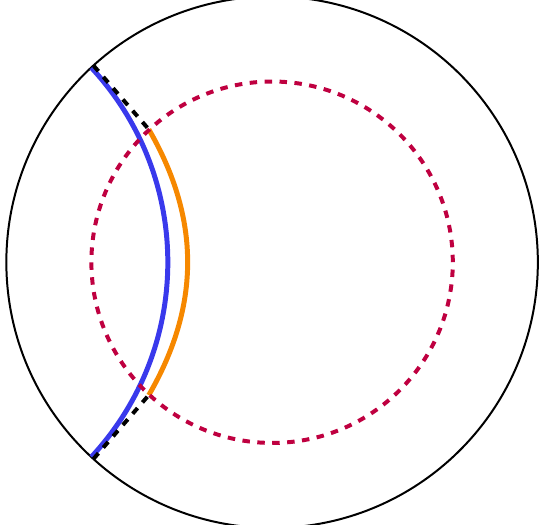
Figure 1 . Two di(cid:11)erent prescriptions for cutting o(cid:11) the area of an extremal surface, shown here in a constant-time slice of vacuum AdS 3 in global coordinates. In the (cid:12)rst prescription, represented in blue, the radial cuto(cid:11) is imposed directly on the boundary-anchored surface. In the second prescription, represented in orange, the boundary region is (cid:12)rst transported to the cuto(cid:11) along radial curves (dashed black lines), then a new extremal surface is found using the initial data of this \transported" boundary. In section 3.2, we show that the two prescriptions give identical answers for the (cid:12)nite di(cid:11)erence in area between two extremal surfaces with the same boundary